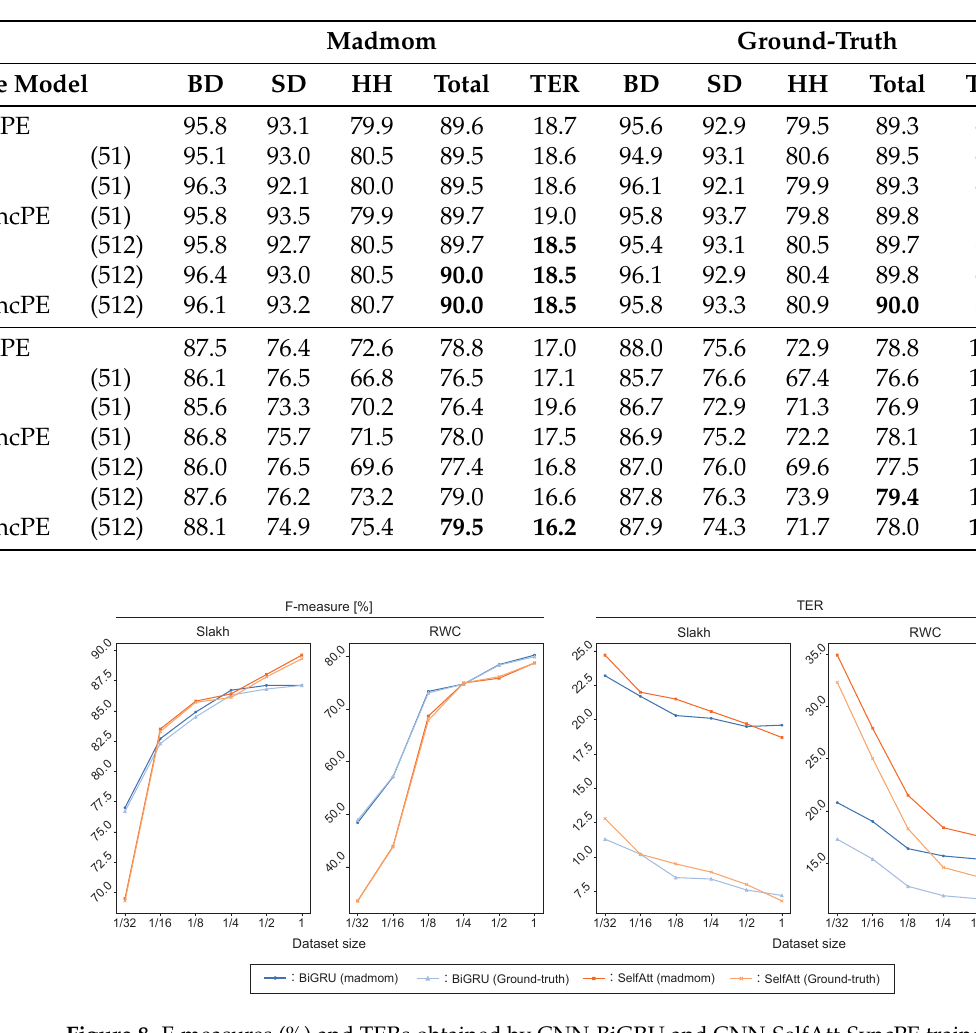
Figure 8. F-measures (%) and TERs obtained by CNN-BiGRU and CNN-SelfAtt-SyncPE trained with 1/32, 1/16, 1/4, 1/2, and all of the training